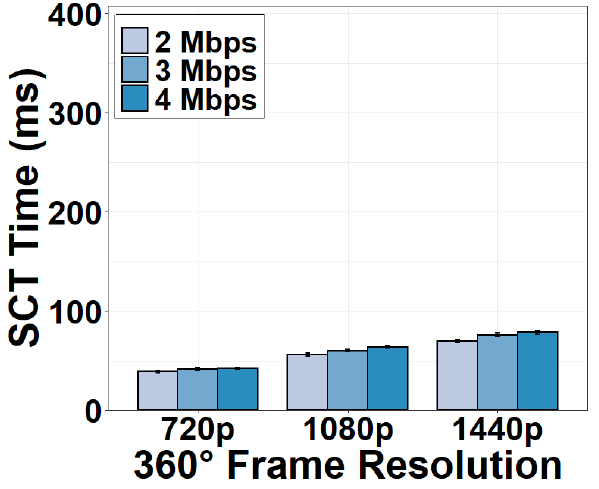
Figure 15. SCT time under different encoding bitrates.